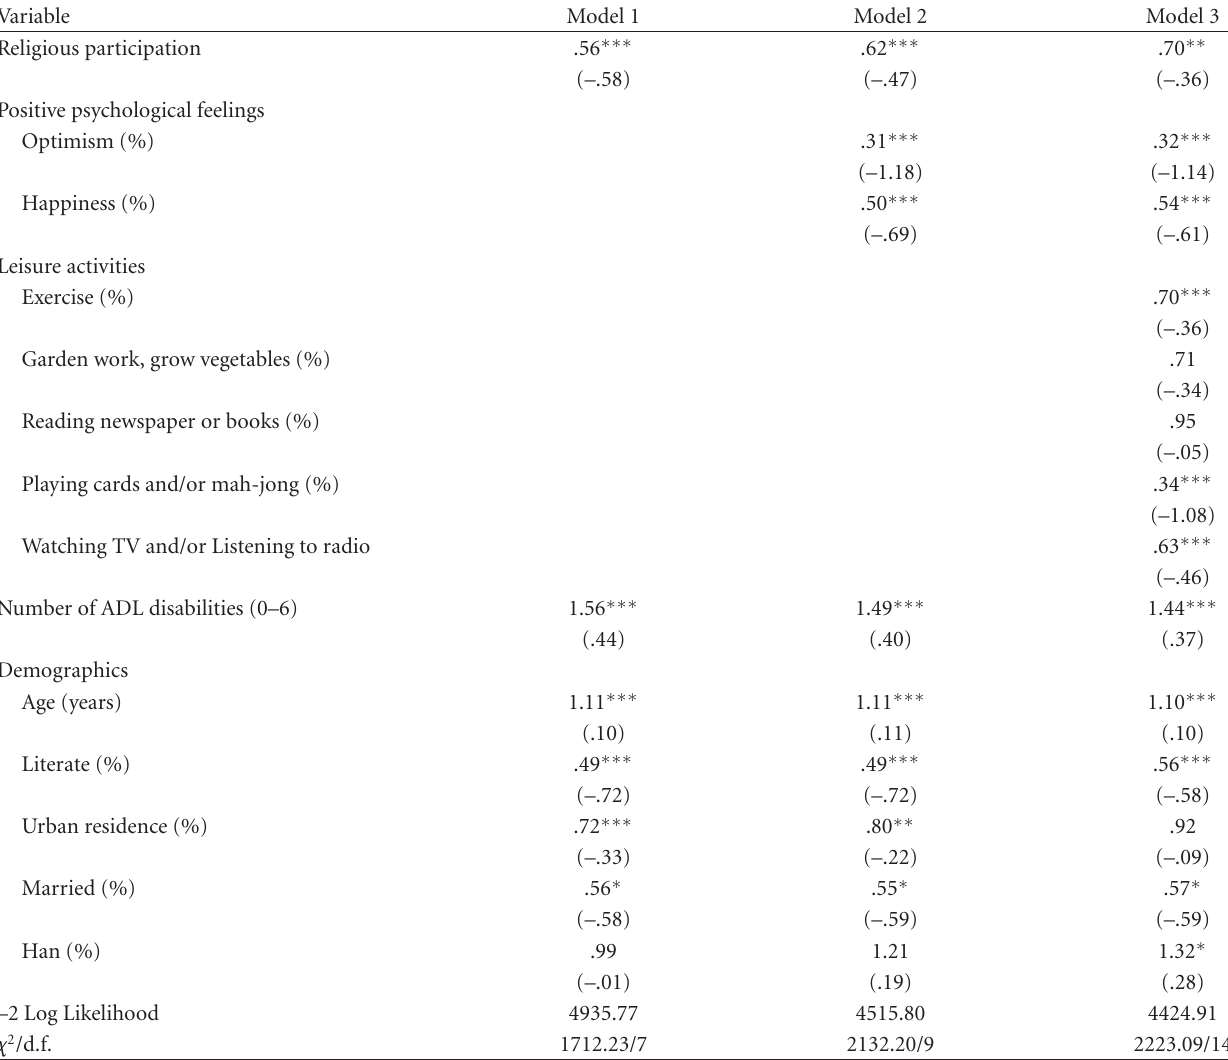
Table 2: Estimated Odds Ratios for religious participation, demographics, and mediators, on cognitive impairment for Women (Logistic Regression Estimate: Oldest-Old Chinese